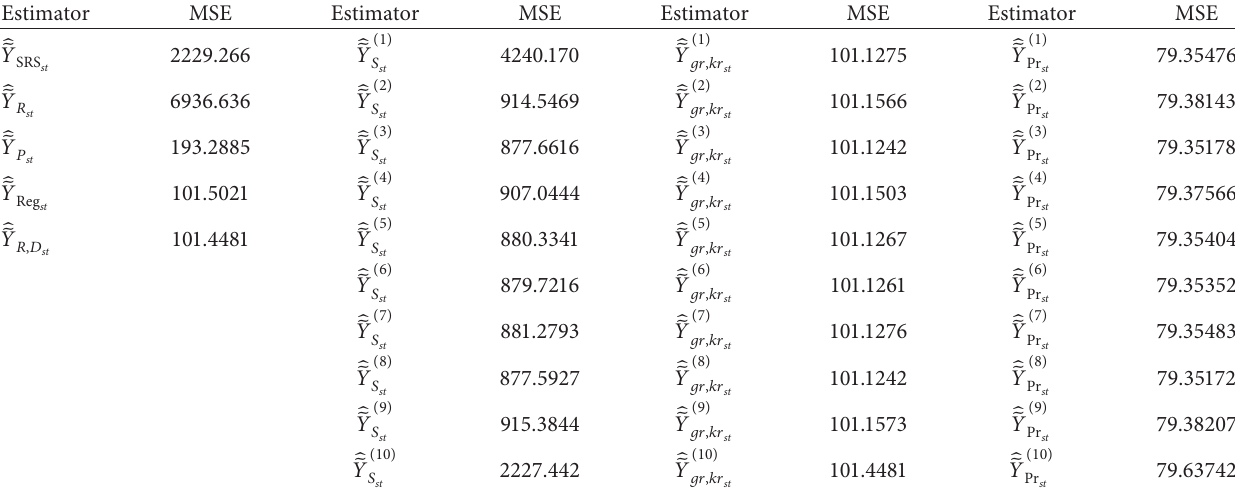
Table 7: MSEs using population 1 (scenario II).